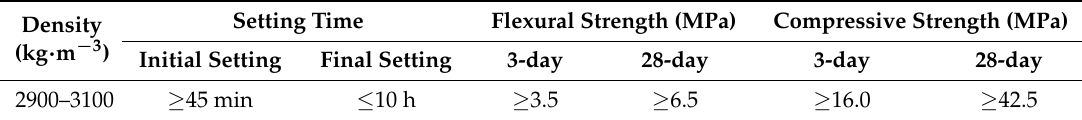
Table 3. Physical Properties of Portland cement, ordinary type P.O. 42.5, conforms to